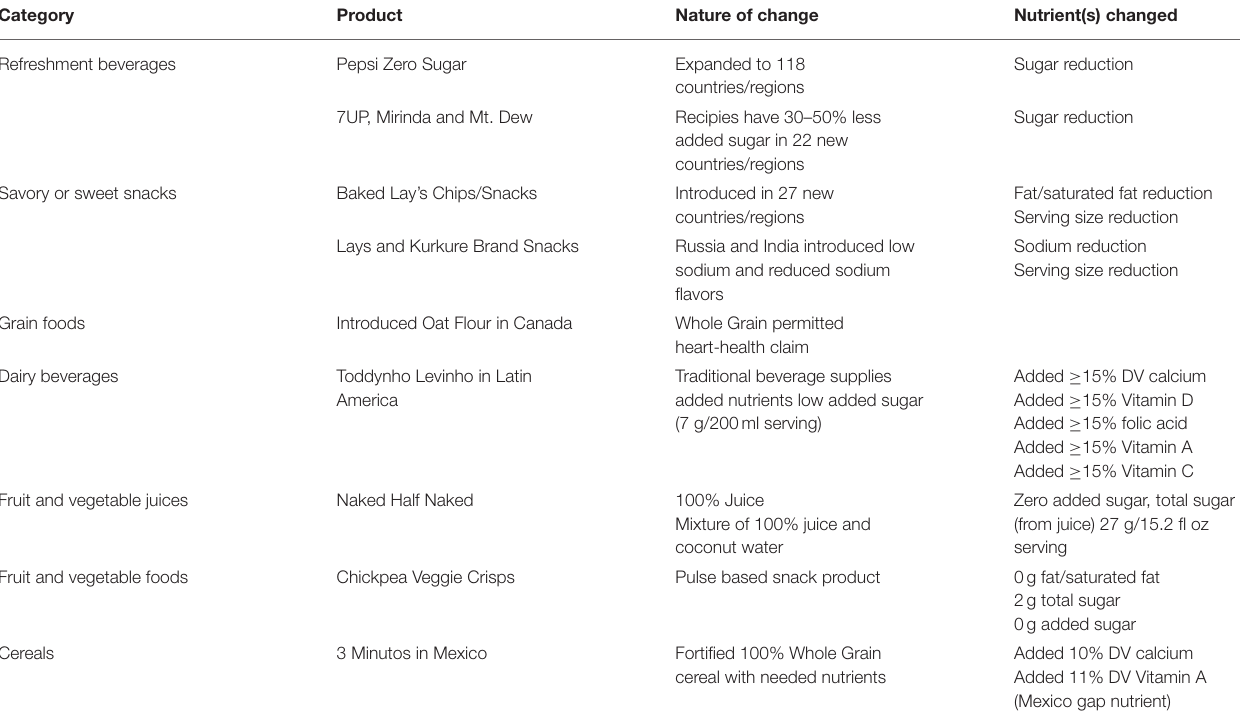
TABLE 7 | Examples of products introduced or reformulated to improve nutrient